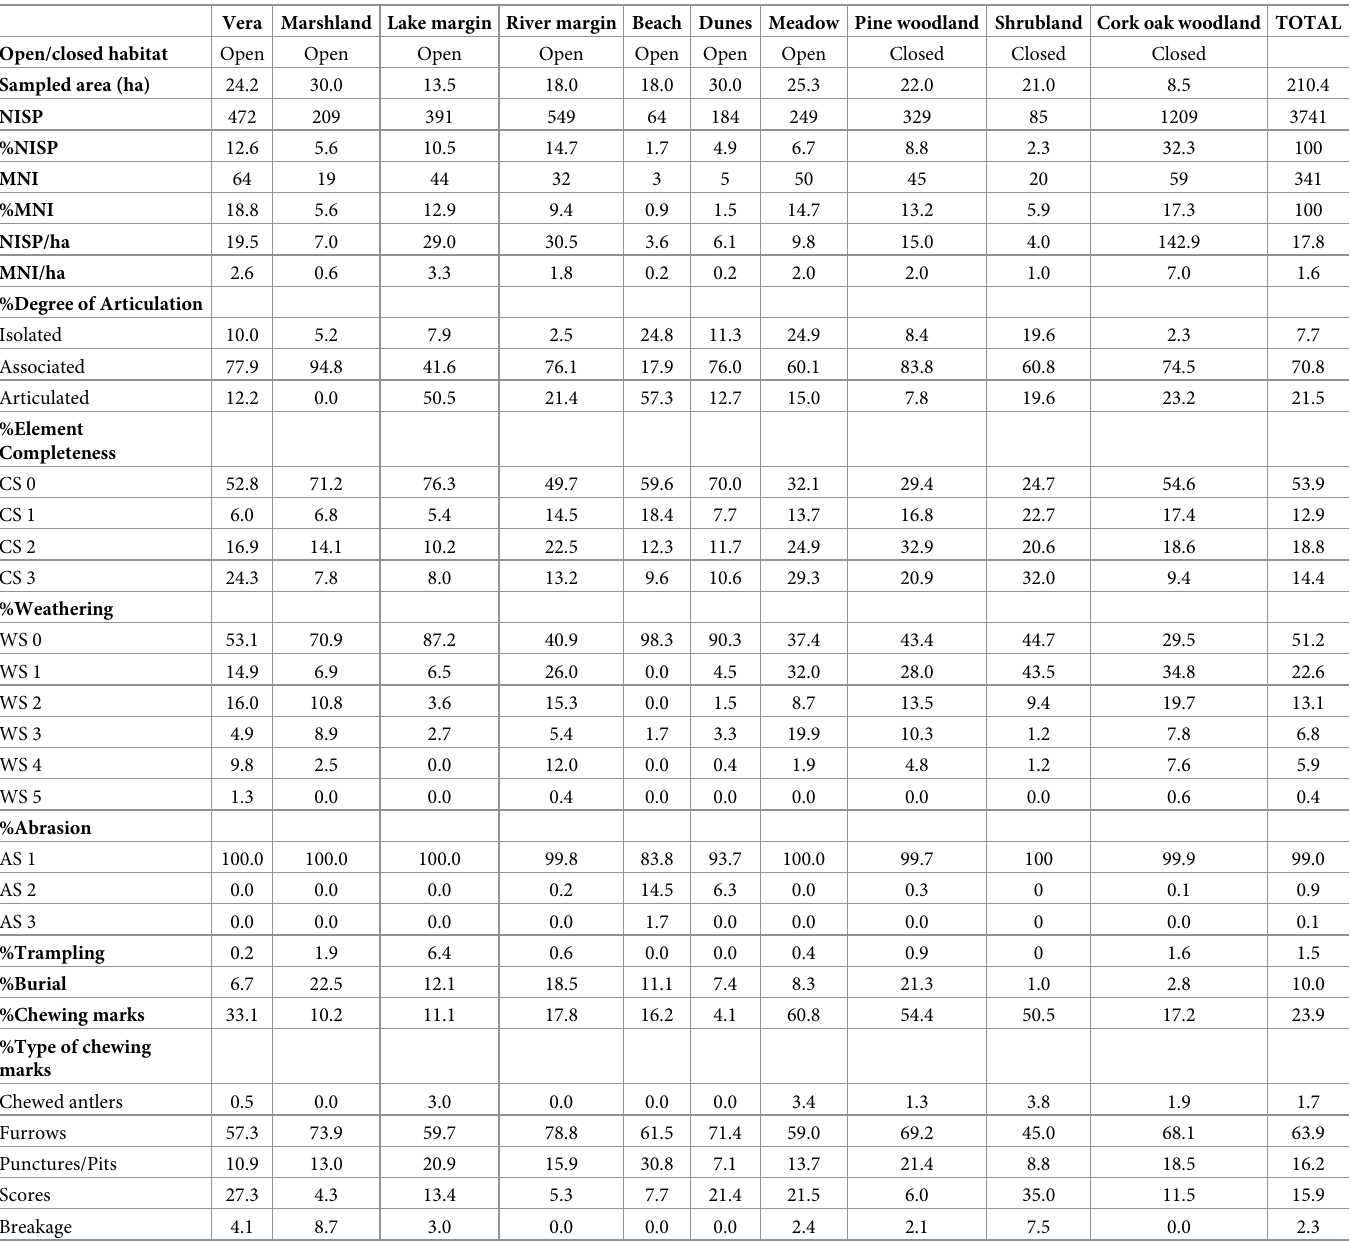
Table 3. Taphonomic characterization of Do ñ ana National Park